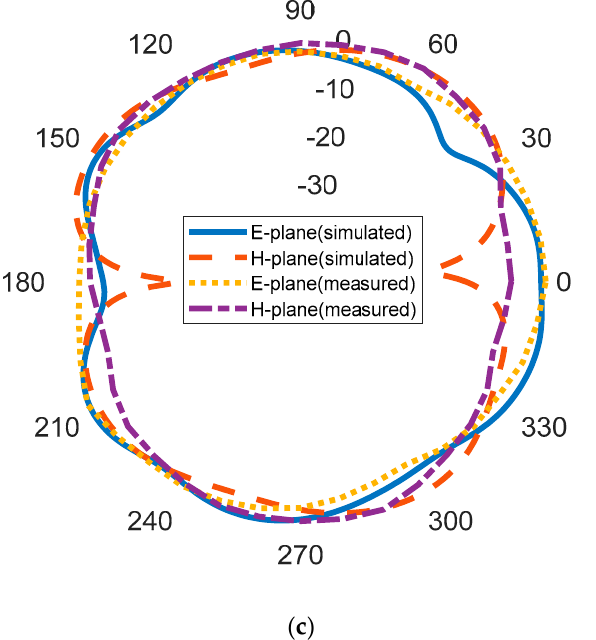
Figure 10. Radiation patterns of the proposed antenna: ( a ) at 6.18 GHz ( b ) at 9.65 GHz ( c ) at 11.5 GHz. The angular 3 dB beamwidth, main lobe direction, total and radiating efficiency, Table 6. Radiation parameters of the I-shaped MTM-based rectangular MPA. maximum gain, and directivity of the proposed antenna are presented in Table 6. It can be observed that as the operating frequency of the antenna increases, the total and radiating efficiency of the antenna decreases. The comparison of the existing works with the I-shaped MTM-based rectangular MPA is presented in Table 7. From this comparison, it can be